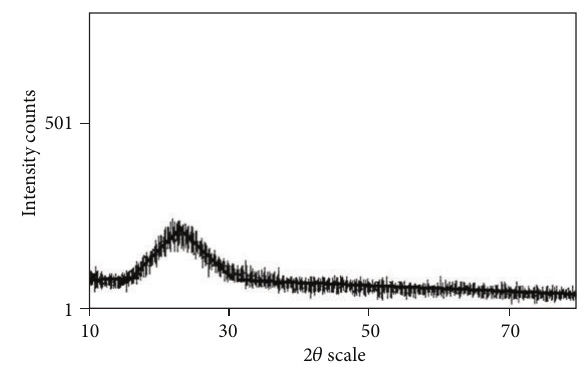
Figure 1: XRD spectrum of silica